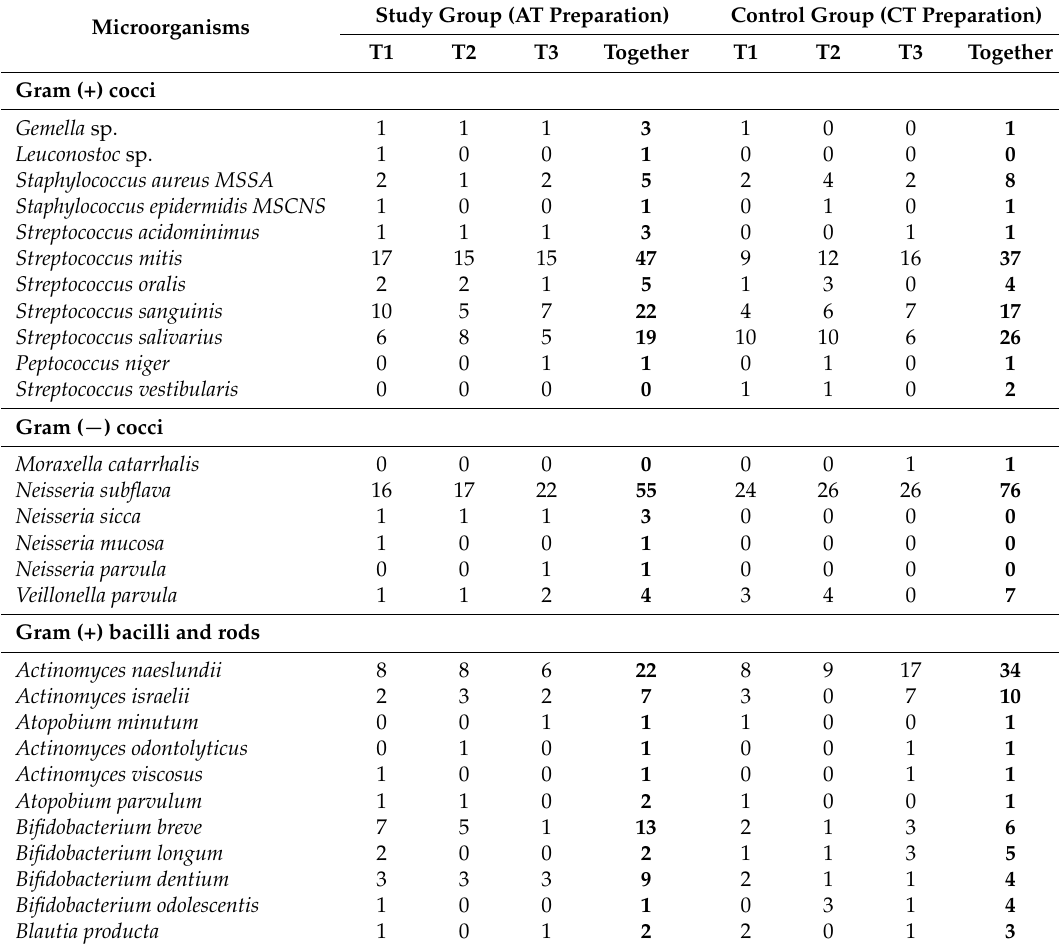
Table 5. Microorganisms found in the samples taken from mouth floor mucosa of patients from study and control groups. Study Group (AT Preparation) Control Group (CT Preparation) Microorganisms